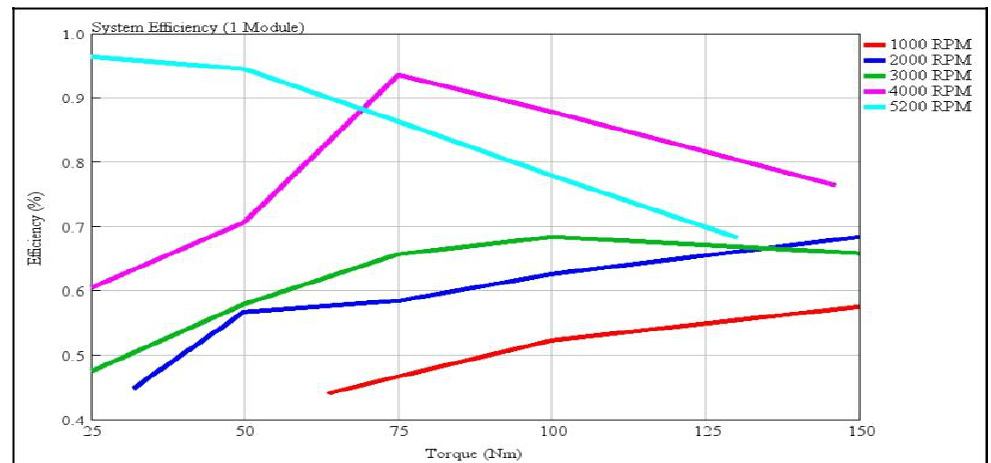
Figure 15. System efficiency of 1 module (25 mm × 25 mm).